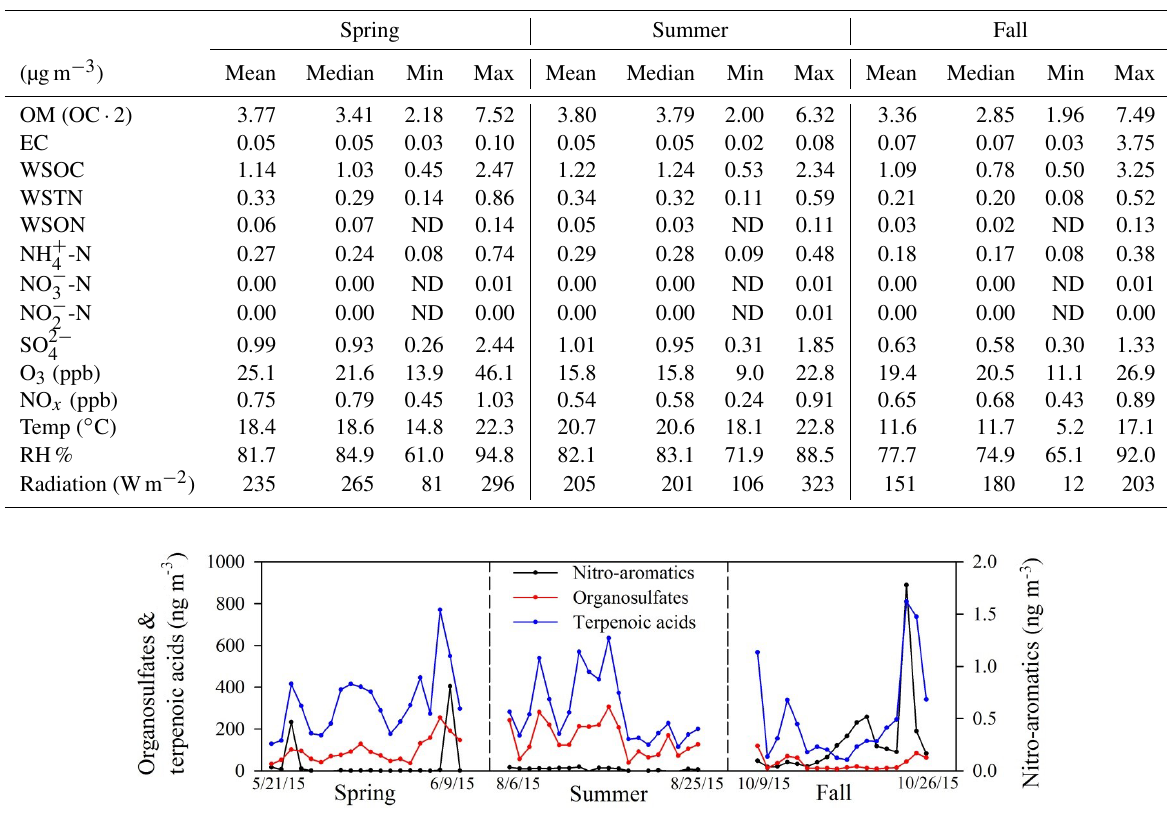
Figure 2. Time series of summed compound group concentrations of nitro-aromatics, organosulfates, and terpenoic acids.